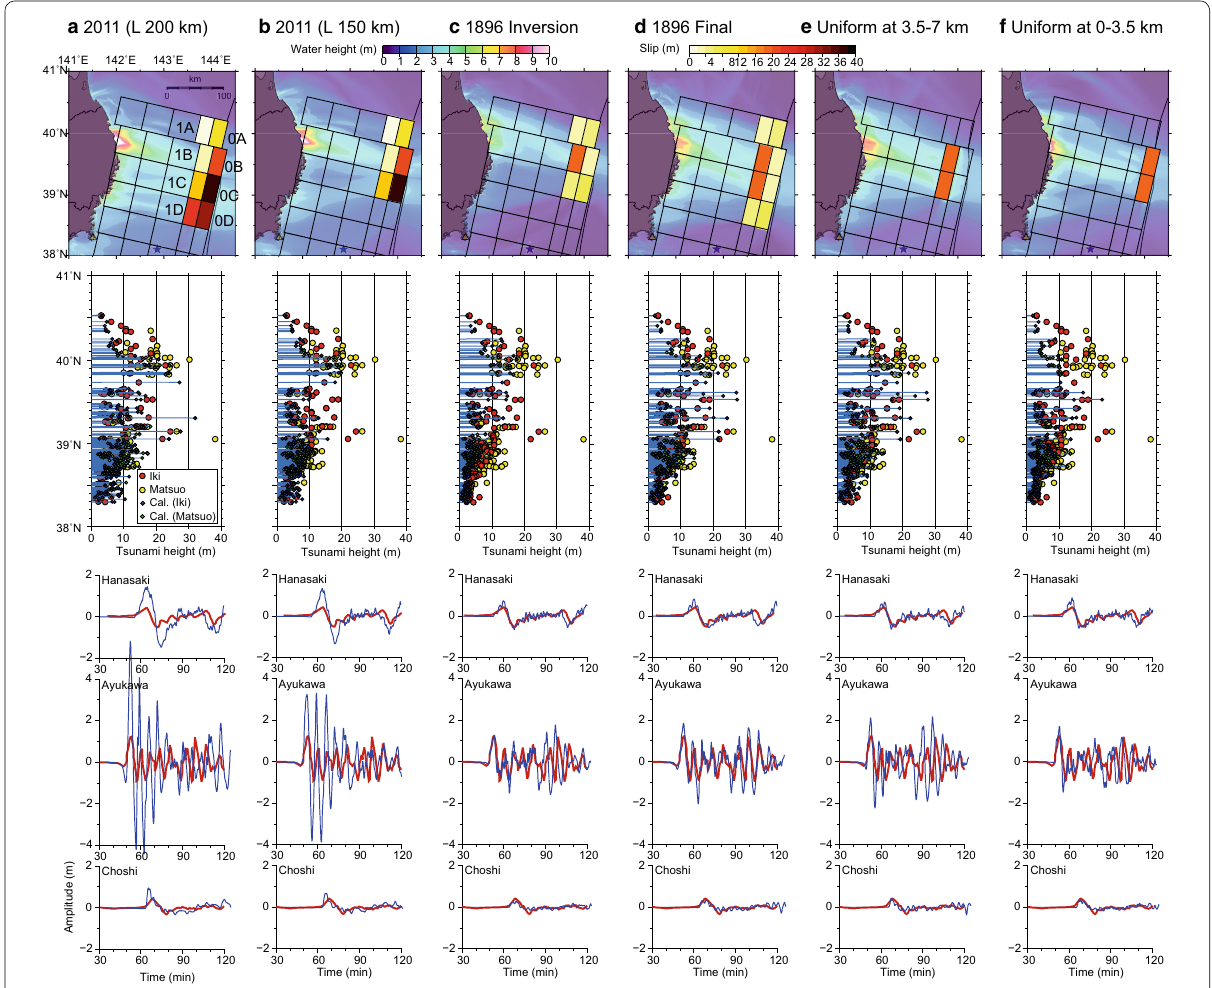
Fig. 2 Comparison of 6 models a 2011 model with 8 subfaults and 200 km long, b 2011 model with 6 subfaults and 150 km long, c 1896 inversion model, d 1896 final model, e uniform (20 m) slip at 3.5–7 km depth, f uniform (20 m) slip at 0–3.5 km depth. (top) Slip distribution on subfaults (color bar scale in the right) and computed maximum tsunami height (color bar scale in the left) for 6 models. (middle) Observed and computed tsunami heights on the Sanriku coast. Red and yellow circles show observed heights by Iki (1897) and Matsuo (1933), respectively. Blue and green circles with bars are computed heights on 6 ″ grid. (bottom) Tsunami waveforms at three tide gage stations at regional distances. Red curves are observed waveforms and blue curves are computed